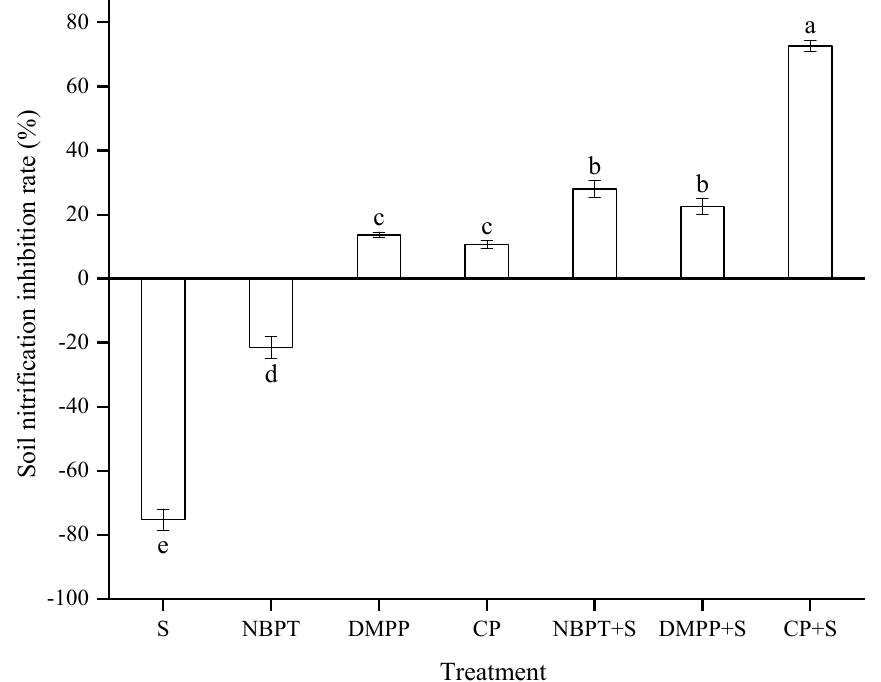
Figure 1. Soil nitrification inhibition rate of different treatments at the seedling stage. Error bars represented standard deviations ( n = 3). Treatments: CK: no N fertilizer; U: urea; S: urea + seaweed extracts; NBPT: urea + N-butyl phos-phorothioate triamine; DMPP: urea + 3,4-dimethylpyrazole phosphate; CP: urea + 2-chloro-6-trimethylpyridine; NBPT + S: urea + N-butyl phosphorothioate triamine+ seaweed extracts; DMPP + S: urea + 3,4-dimethylpyrazole phosphate + seaweed extracts; CP + S: urea + 2-chloro-6-trimethylpyridine + seaweed extracts. Different letters indicate significant differences between different treatments at p < 0.05 by Tukey